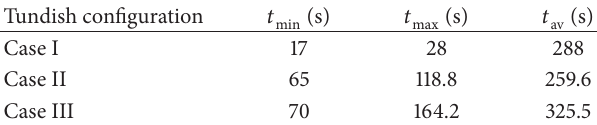
plane of the bare tundish ( 𝑥 = 0 , −1.066 ≤ 𝑦 ≤ 0.324 ,